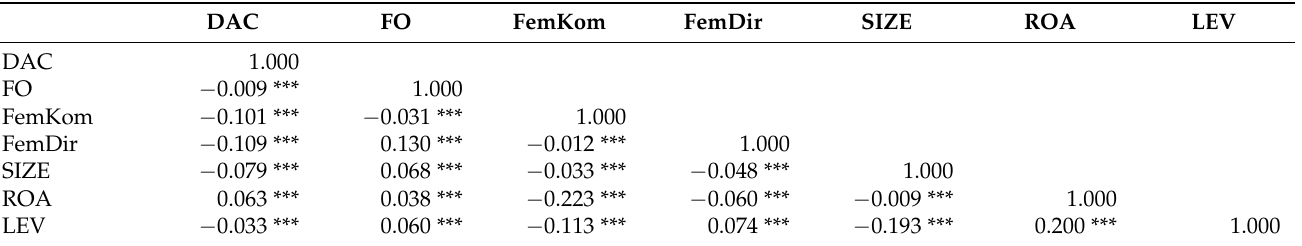
Table 3. Correlation Matrix.